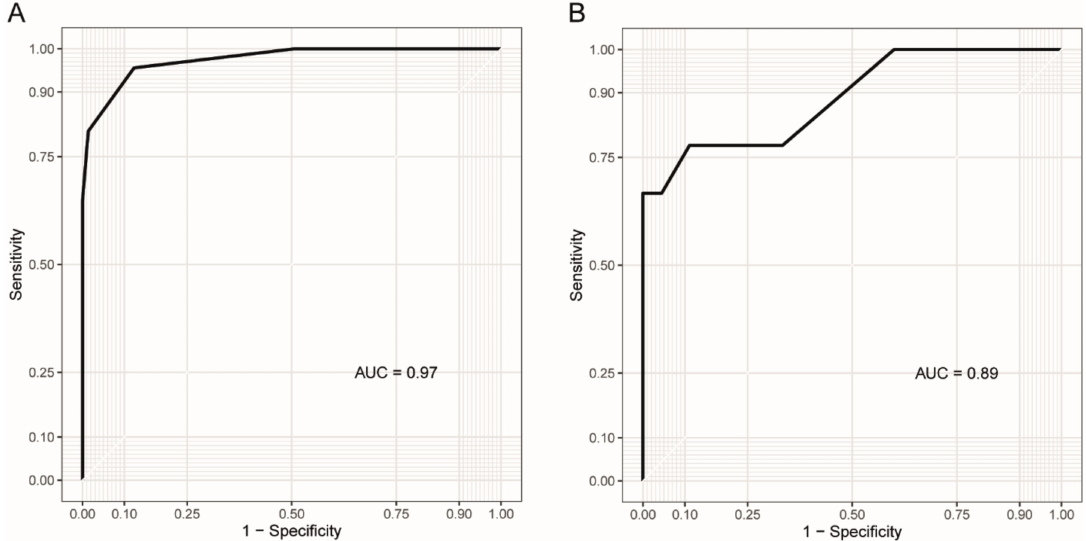
Figure 5. Receiver-operating characteristic (ROC) curves illustrating how methylation at downstream CpG14 can be used as ( A ) a biomarker for DM1 and ( B ) to identify patients with maternal transmission of the disease allele. The y -axis shows the rate of true positives, while the x -axis shows the rate of false positives. AUC = Area under the